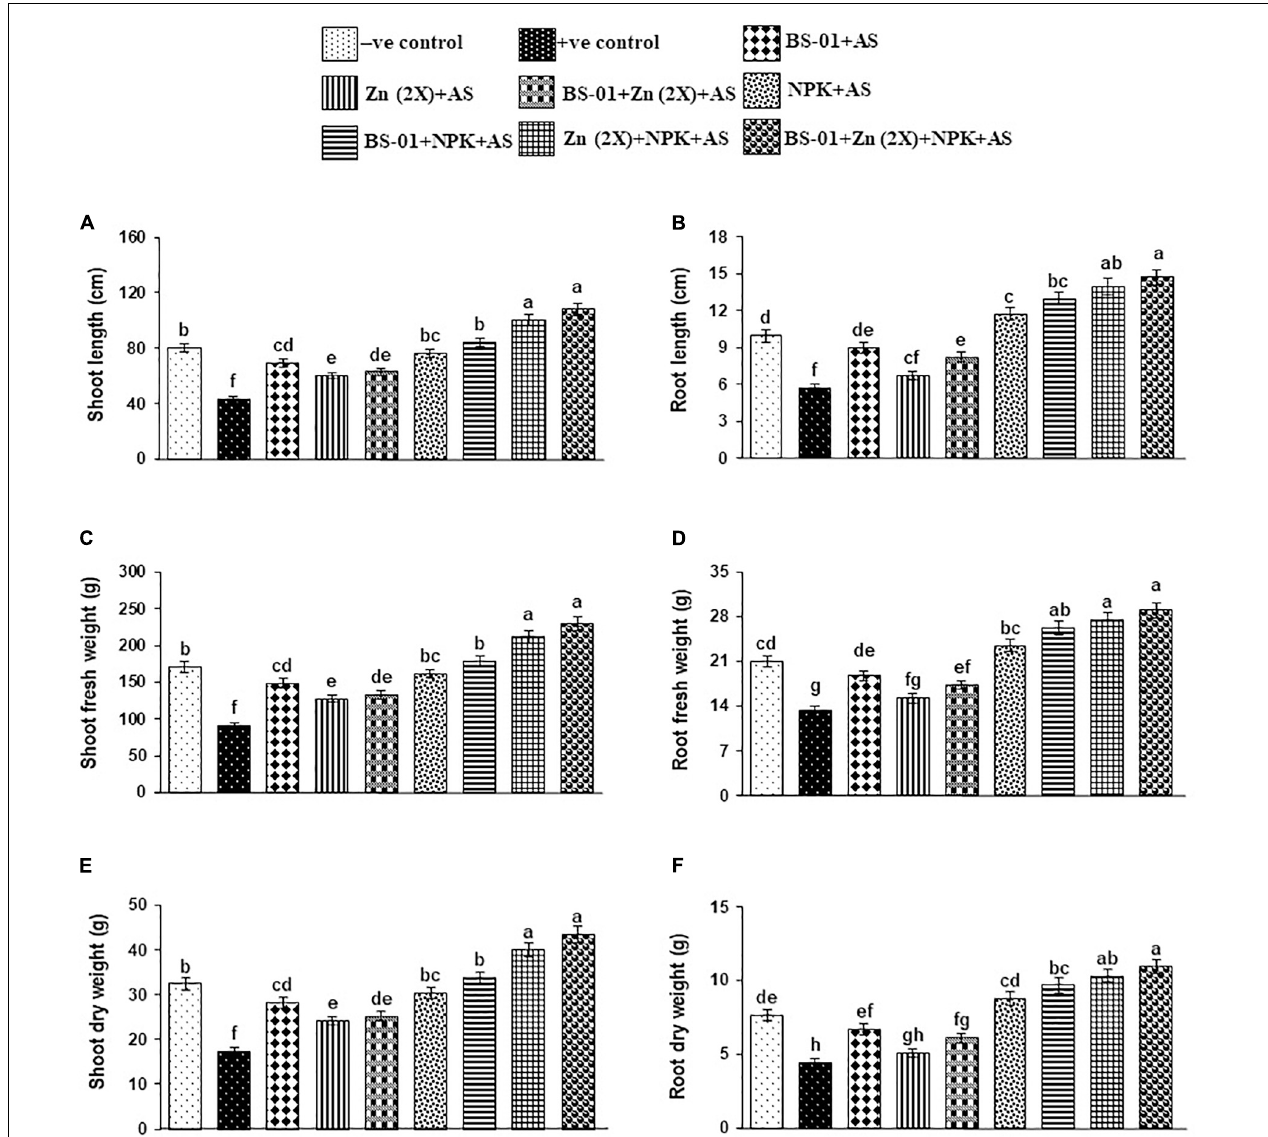
FIGURE 4 | (A–F) Effect of Bacillus subtilis (BS-01) and mineral nutrients [Zn (2X: 10 kg acre − 1 ) and NPK (64:46:50 kg acre − 1 )] on the shoot length (A) , shoot fresh weight (B) and shoot dry weight (C) , root length (D) , root fresh weight (E) , and root dry weight (F) of tomato plants inoculated with Alternaria solani (AS) in the field after 60 days of pathogen inoculation (DPI). Values with different letters show a significant difference ( p ≤ 0.05) in the mean value of replicates as determined by the LSD test. Error bars indicate standard errors of the mean of replicates ( N = 2). − ve control, without inoculation of AS and nutrient application; +ve control, with inoculation of AS only (foliar